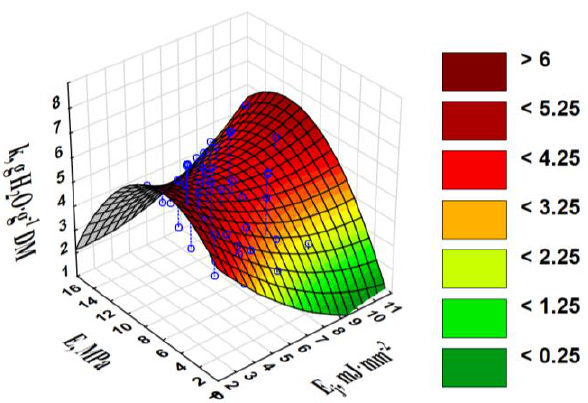
Figure 5. Water absorption by crushed pellets k vs. fraction particle size x and water absorption by uncrushed pellets k u .